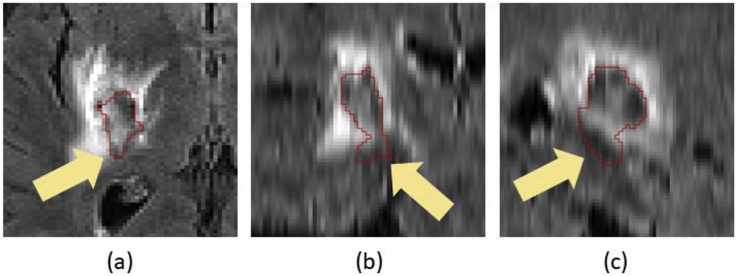
Worst case of haematoma segmentation on Dataset A. (a) FLAIR, axial. (b) FLAIR, coronal. (c) FLAIR, sagittal. Note that there is over-segmentation (yellow arrows) due to attenuated FLAIR intensities within oedema.